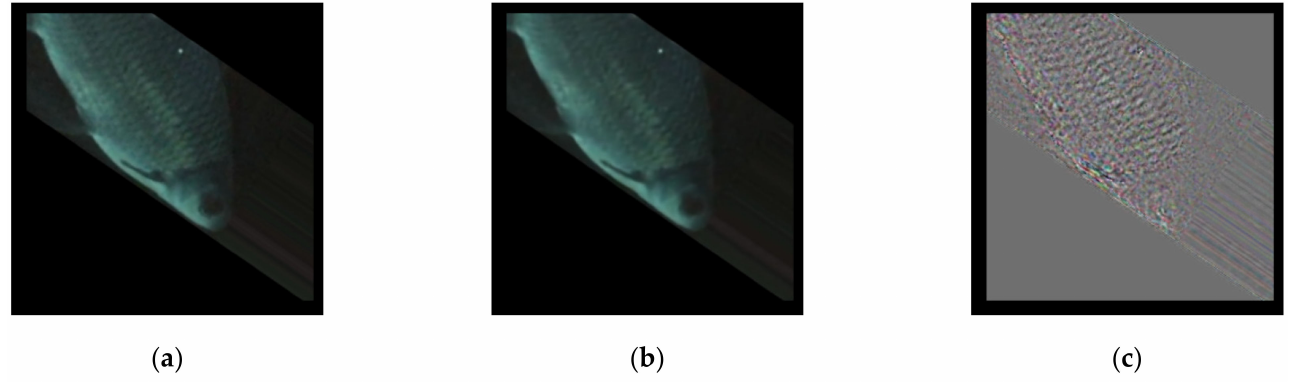
Figure 6. The CNN autoencoder sample results: ( a ) source, ( b ) reconstructed, and ( c )